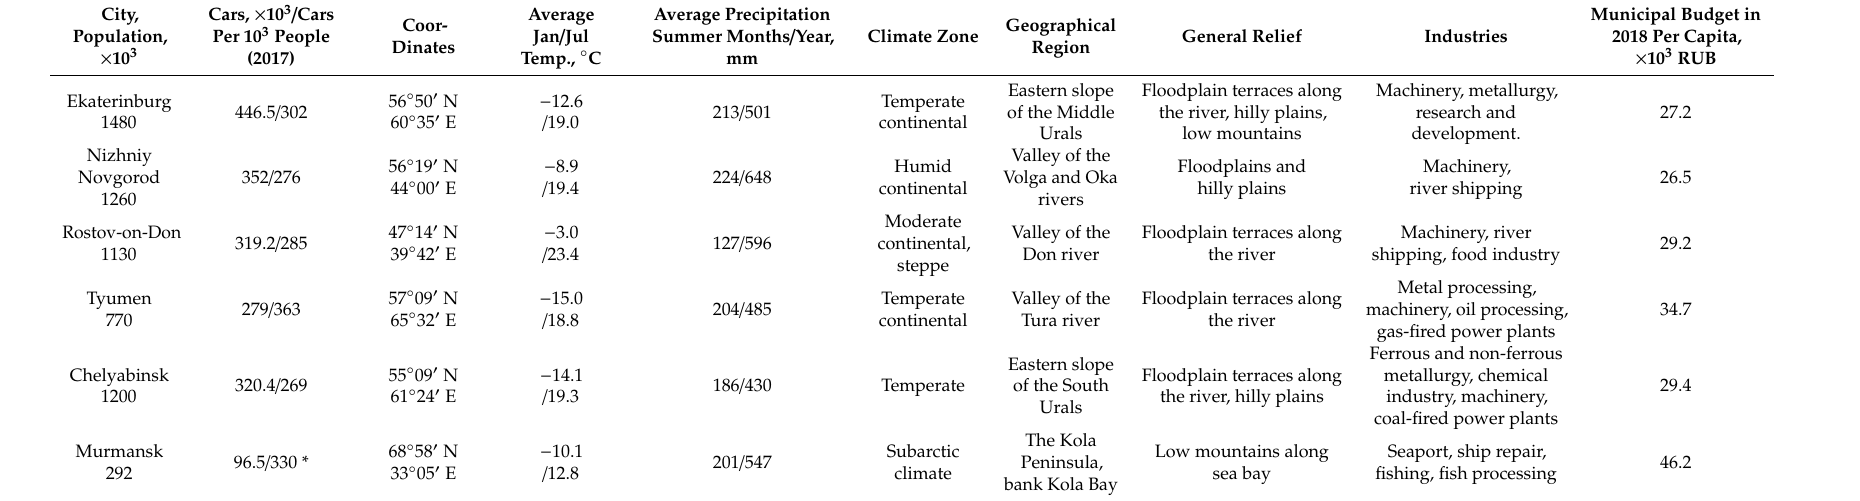
Table 1. Characteristics of cities